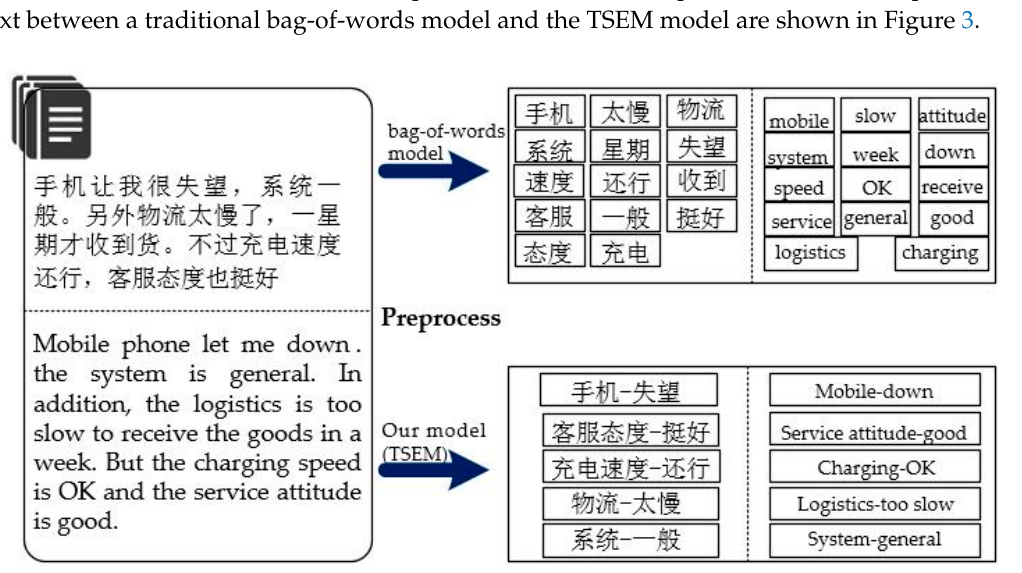
Figure 2. The overall framework of emotion mining for online comments.